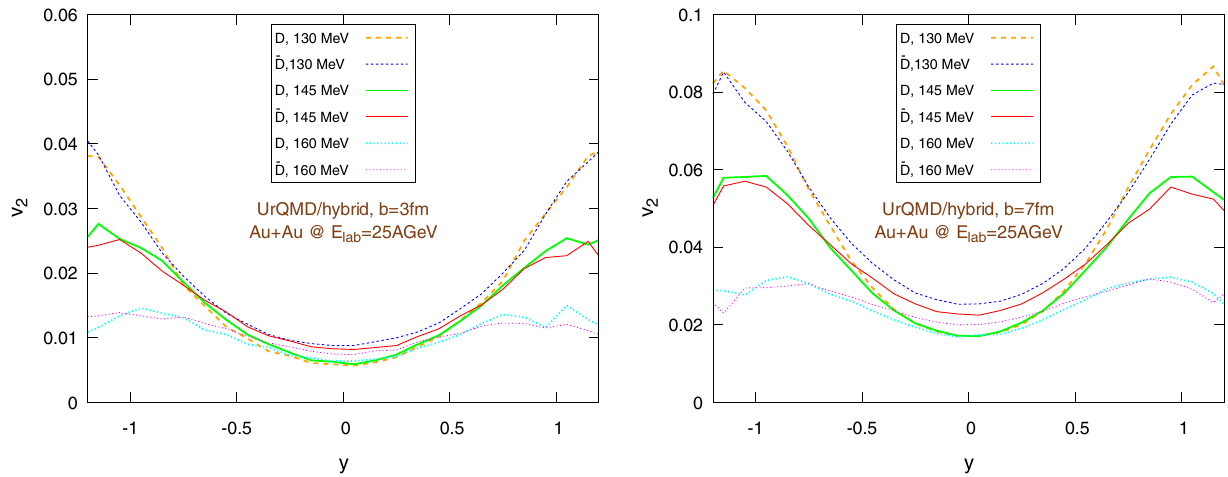
Fig. 20 Elliptic flow of D / ¯ D mesons with respect to rapidity within the UrQMD/hybrid model in Au+Au collisions at E lab = 25 AGeV. We show different hadronization temperatures, with fixed parameters: (cid:23) p = 0 . 05 and